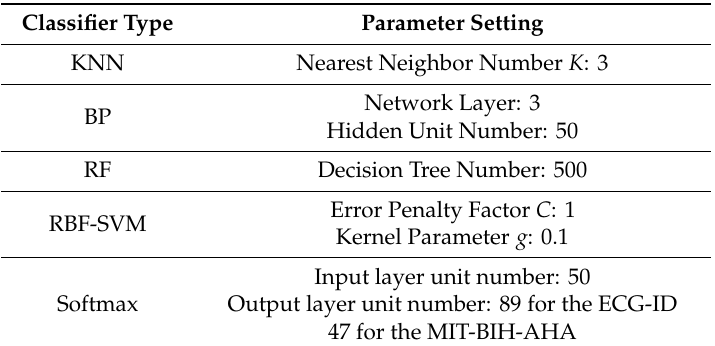
Table 4. Key parameter settings of five